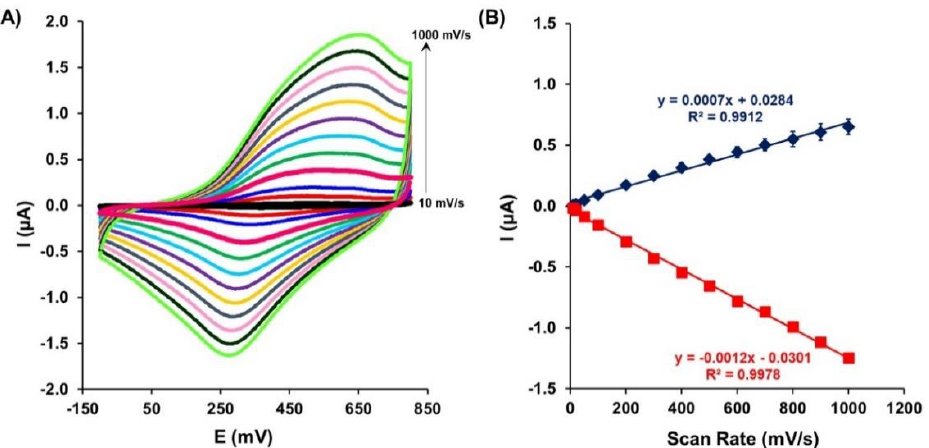
Figure 2. ( A ) Cyclic voltammograms recorded for the constructed aptasensor at different scan rates: 10, 20, 50, 100, 200, 300, 400, 500, 600, 700, 800, 900, and 1000 mV/s. ( B ) Linear relationship between